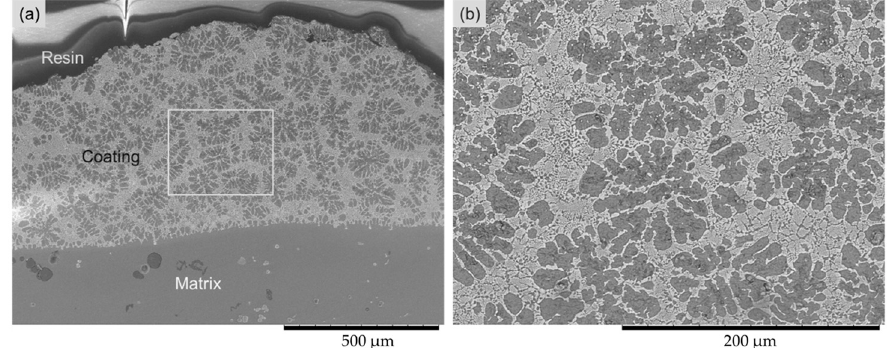
Figure 3. A Cross-section of the as-diffusion-alloyed intermetallic layer on an AZ91D magnesium alloy specimen with zinc oxide as the only Zn donor in the diffusion source ( a ) and partially enlarged zone ( b ) which is marked with a rectangle in ( a ).